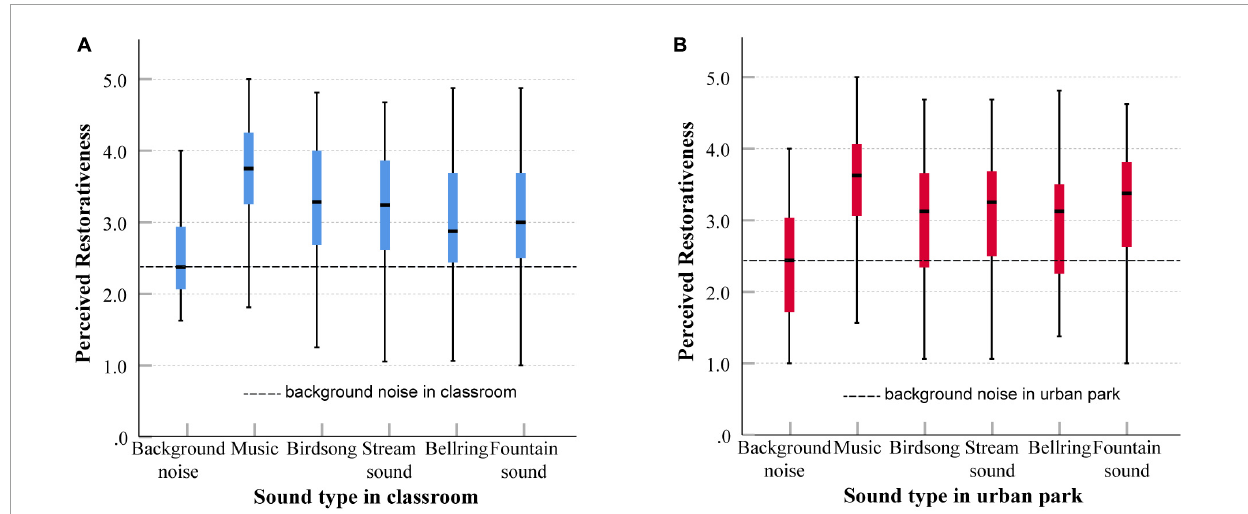
FIGURE10 Boxplots of perceived restorativeness of each sound type in the context of a classroom (A) and urban park (B) , showing median, interquartile range, maximum, and minimum